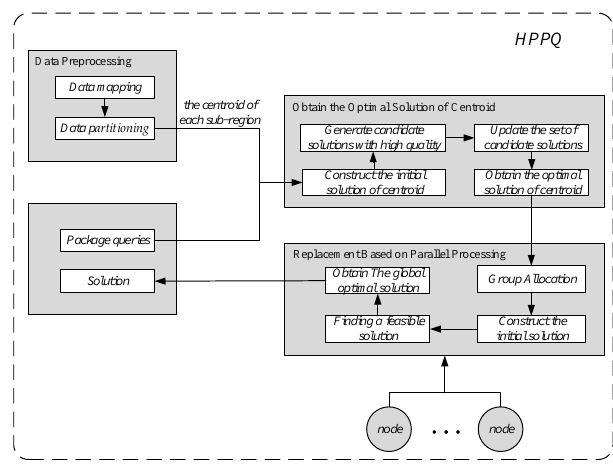
Fig. 1 Query processing